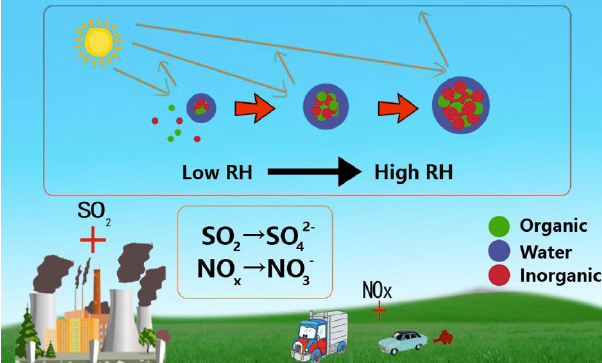
Figure 7. A schematic picture illustrating the process of enhanced emission of inorganic aerosol precursors and formation of in- organic aerosol components, leading to increased hygroscopicity and aerosol water uptake ability, leading to considerable visibility degradation in China. The plus symbols represent the strengthening of a specific